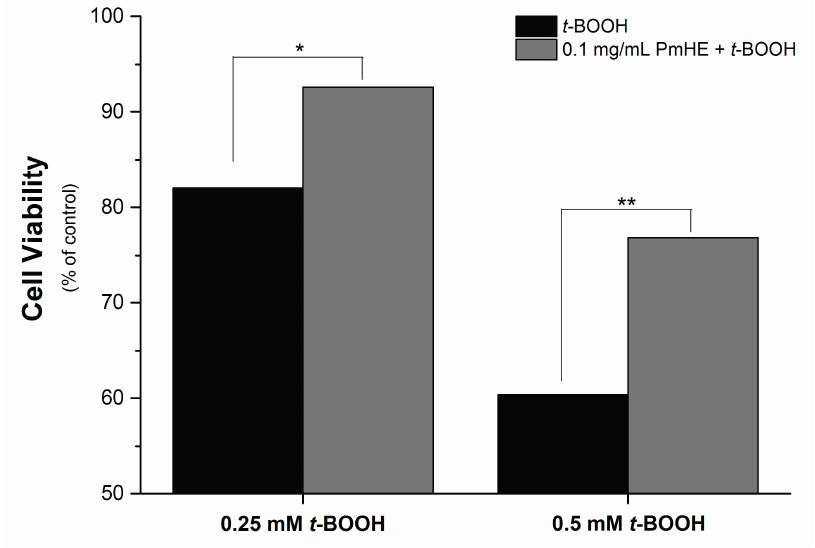
Figure 4. Cytoprotective effect of P. major hydroethanolic extract against t -BOOH-induced cell death. HepG2 cells (1.6 × 10 5 cells/cm 2 ) were incubated for 24 h in Dulbecco’s modified Eagle’s medium supplemented with 10% fetal bovine serum at 37 °C in a 5% CO 2 atmosphere with 0.25 or 0.5 mM t -BOOH in the presence (gray bars) and absence (black bars) of 0.1 mg/mL PmHE. Both, t -BOOH and PmHE were added at the same time. * / ** Statistically different from 0.25 and 0.5 mM t -BOOH, respectively ( p <